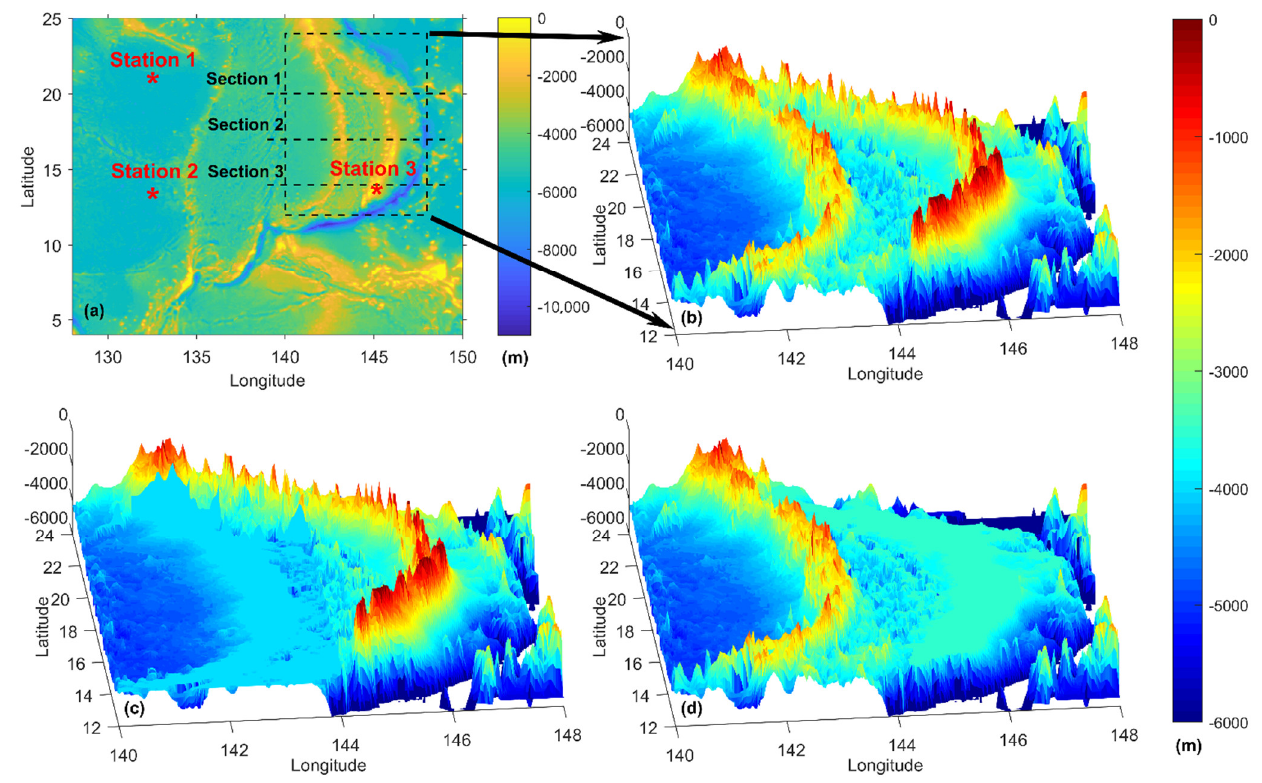
Figure 1. Model domain and bathymetry in the northwest Pacific ( a ). The black dashed box is the target area in this study. Zonal Section 1, Section 2, and Section 3 are selected at the latitude of 20° N, 17° N, and 14° N, respectively. Red stars represent the mooring observation stations. Detailed topography at the target area under DR ( b ), SE ( c ), and SW ( d ) cases.